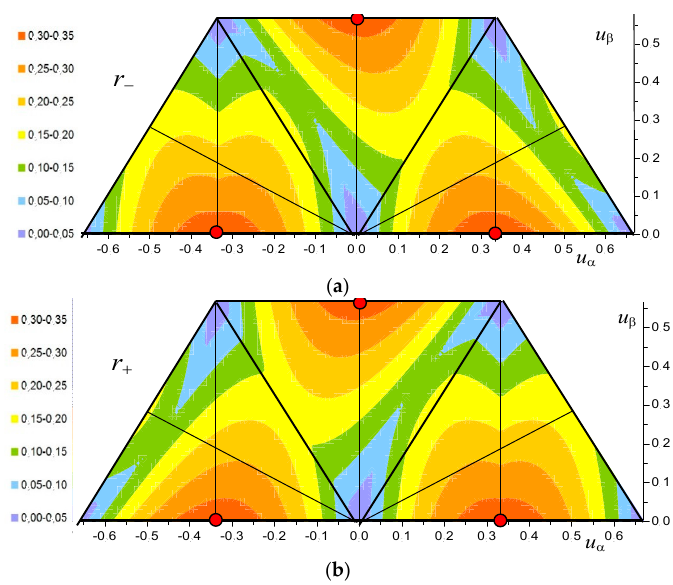
Figure 16. Maps of normalized current ripple in the normalized output voltage plane: ( a ) negative clamped, DPWM − ; and ( b ) positive clamped, DPWM+. The maxima of the ripple are emphasized with red dots.